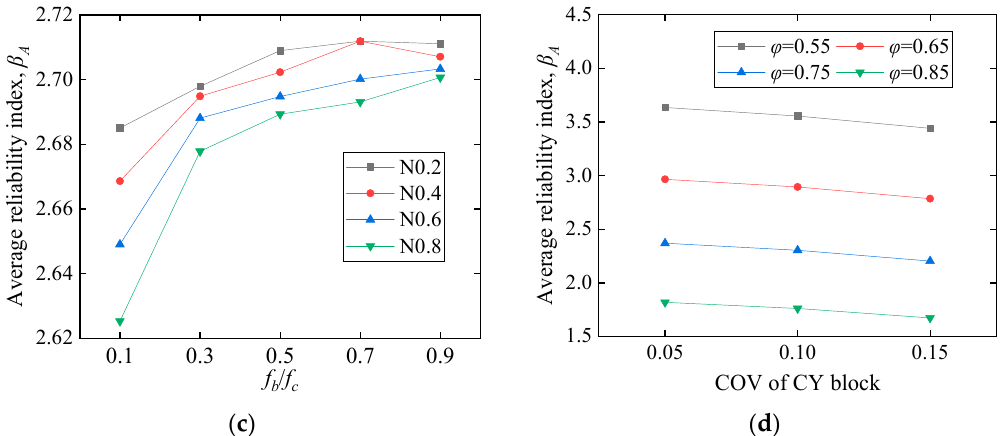
Figure 10. Effect of CY block properties on the average reliability index. ( a ) Effect of f b /f c on β A, ( b ) effect of η on β A , ( c ) the combined effect of f b /f c and η on β A , ( d ) effect of cov of CY block on β A.